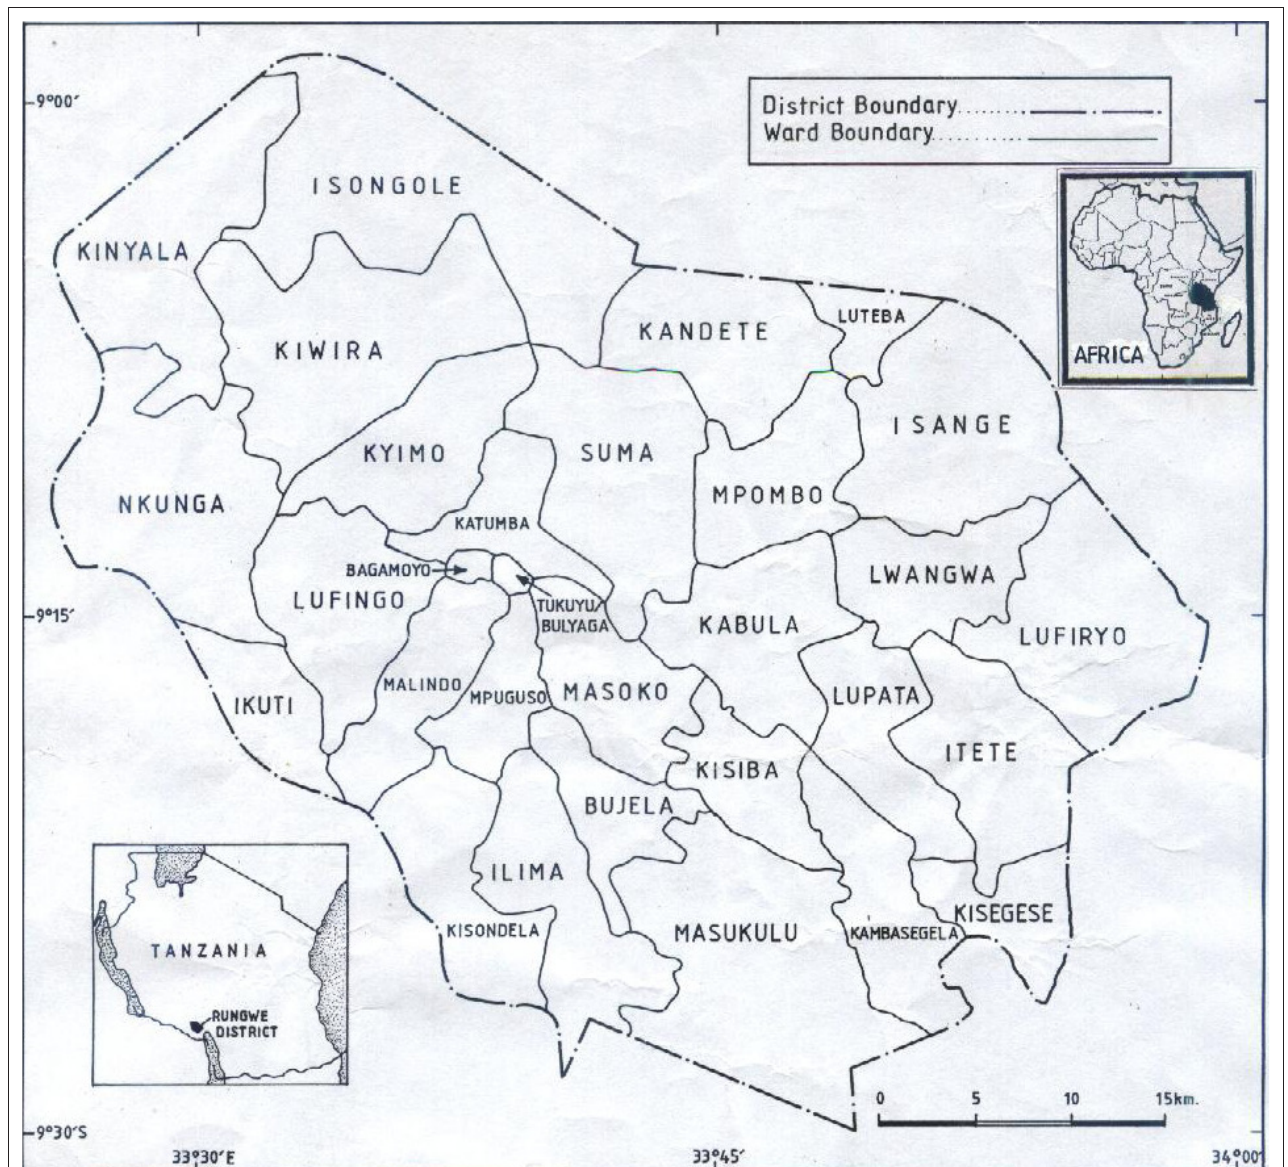
FIGURE 1: Map of Rungwe District showing location and division of